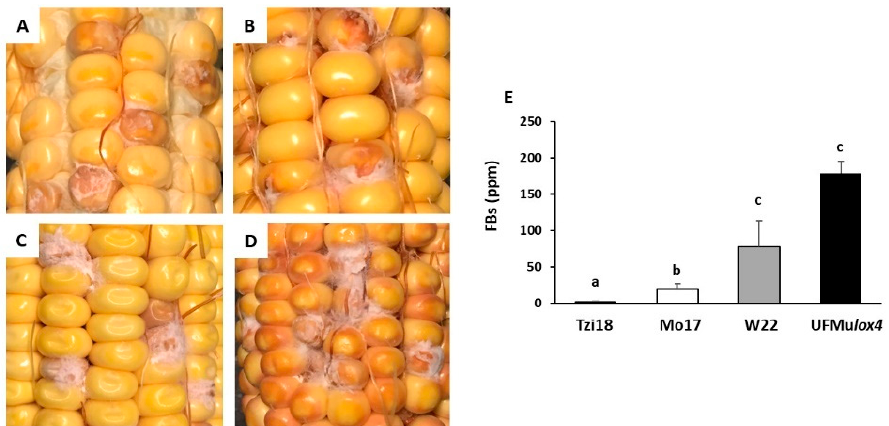
Figure 2. Phenotypic evaluation of Fusarium ear rot disease among the lines ( A ) Tzi18, ( B ) Mo17, ( C ) W22, ( D ) UFMu lox4 mutant, and ( E ) content of total fumonisins (FBs, B 1 + B 2 + B 3 ) in artificially inoculated kernels at 7 dpi with F. verticillioides . Vertical bars indicate the standard error. The different letters over the histograms indicate significant differences in the fumonisin content among the tested lines as resulting from the Tukey multiple comparison test ( p ≤ 0.05).